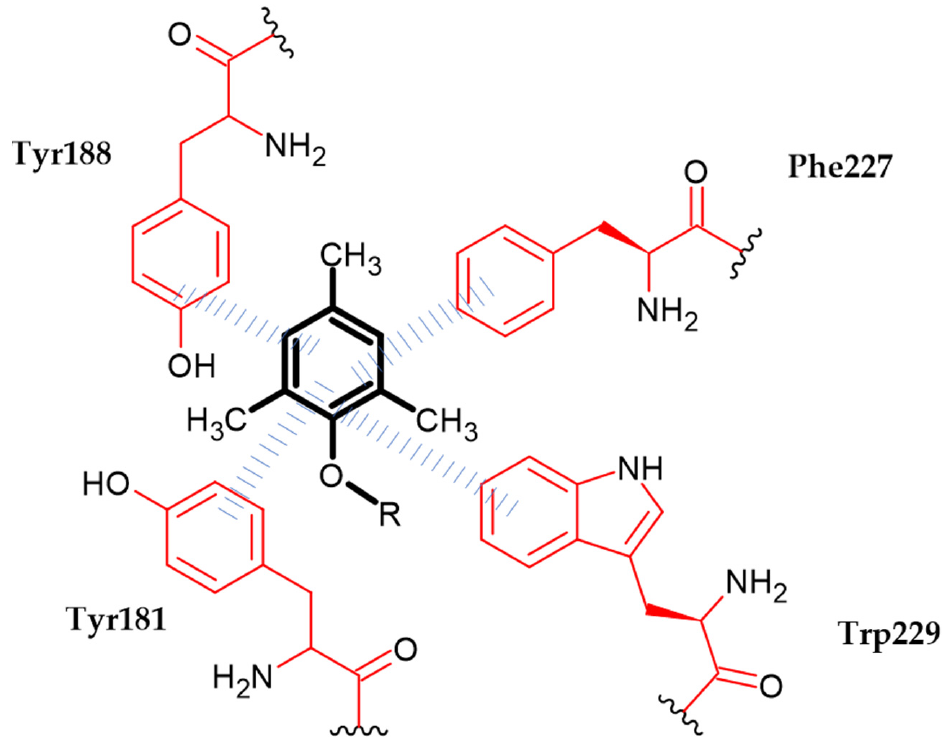
Figure 21. Schematic representation of the π – π interaction (blue lines) formed by a phenoxy group (R is the rest of the compound structure).